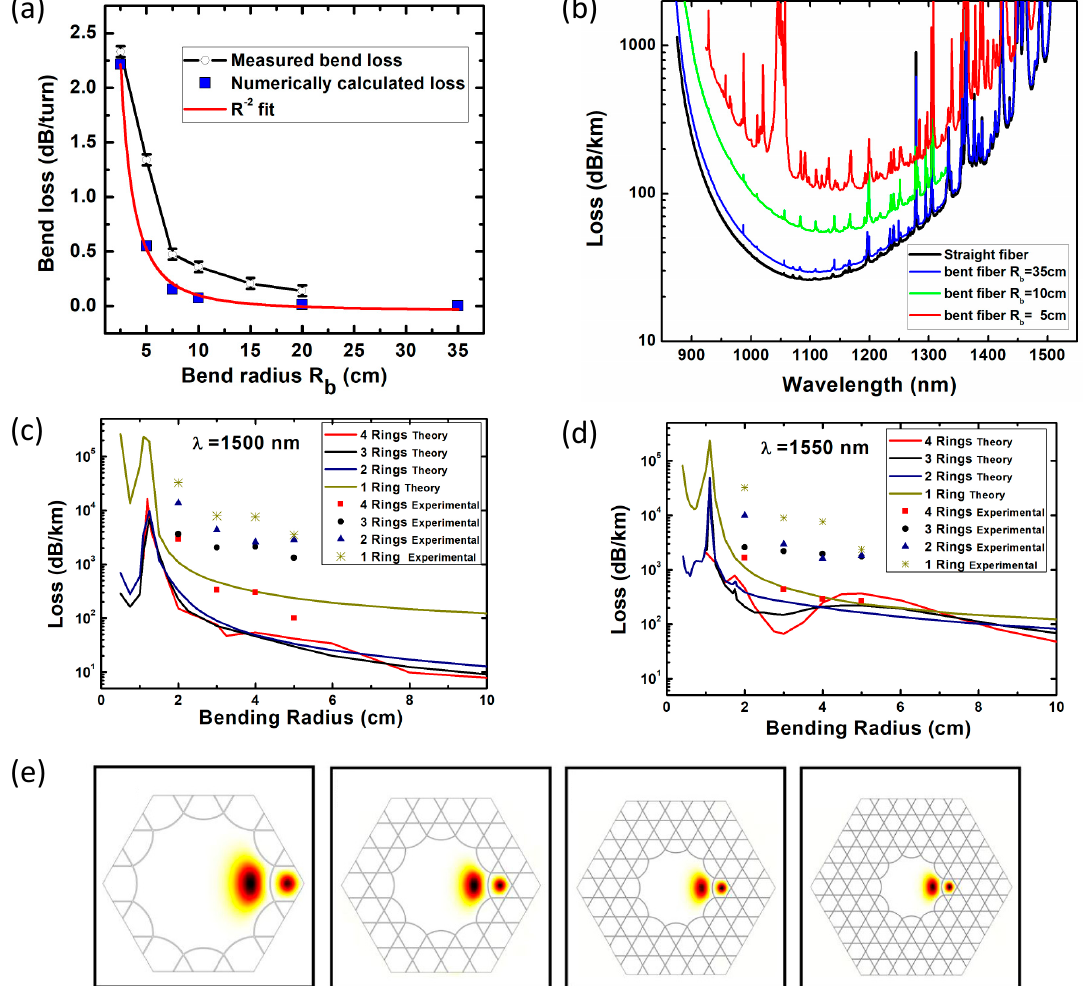
Figure 17. Calculated and measured bend loss evolution at λ = 1064 nm with bend radius ( a ), and ( b ) loss spectra for different bend radii of HE 11 core mode of a hypocycloid-core Kagome HCPCF (reprinted with permission from Reference [83], OSA, 2013). Calculated and measured loss evolution with bend radius for a hypocycloid-core Kagome HCPCF with b = 0.3, t ≈ 440 nm, and R in between 23.5 and 29 µm, and having different cladding ring number at 1500 nm ( c ) and 1550 nm ( d ). ( e ) The calculated intensity profile of the mode when the fiber is under a bend of a radius of 1.1 cm for Kagome IC HCPCF with different cladding ring number (reprinted with permission from Reference [83], OSA, 2013).